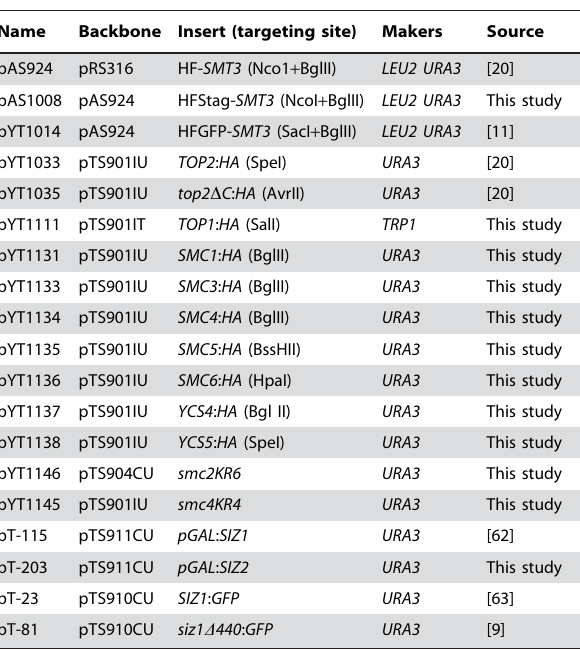
Table 1. Plasmids.